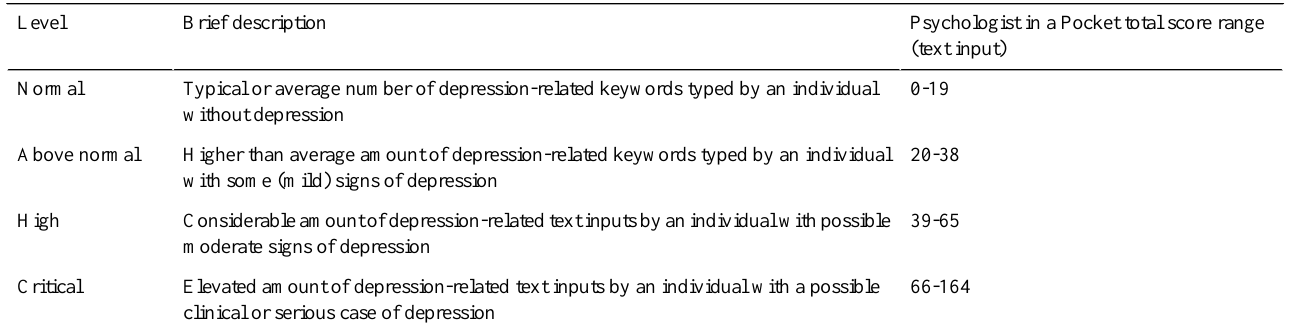
Table 4. Psychologist in a Pocket total score interpretation. input)Brief descriptionLevel